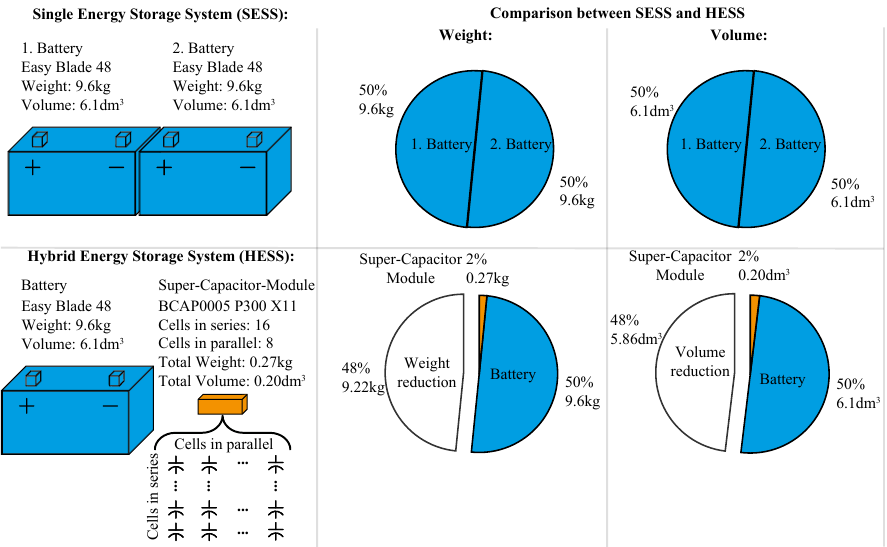
Figure 18. Estimated volume and weight breakdown for topologies VI and VIII and reduction in weight and volume compared to the SESS